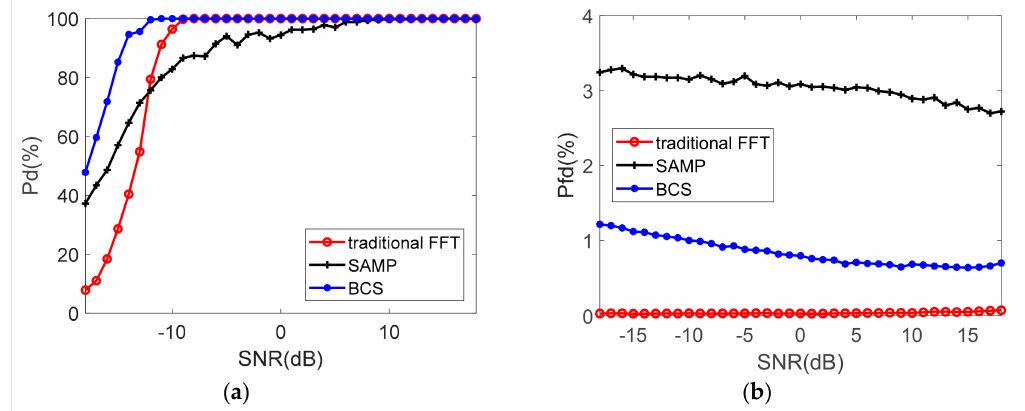
Figure 8. The probability of detection ( a ) and false detection ( b ) (single target, η =